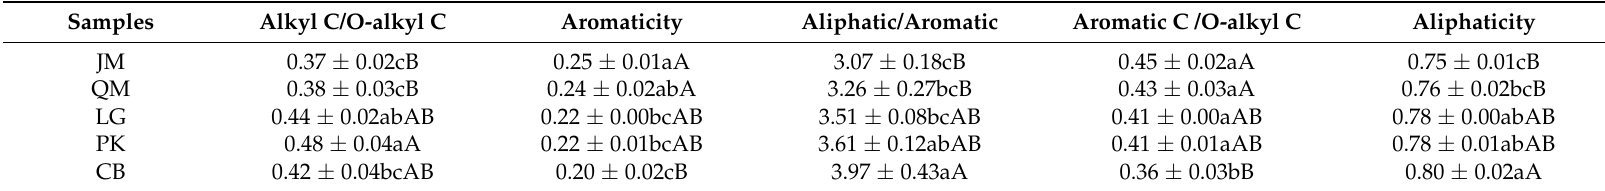
Table 3. Ratios of different SOC chemical functional groups under five different revegetation